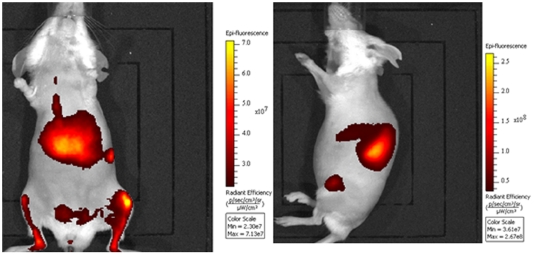
Fluorescence imaging of patient AML cells bearing mice performed 24h after intravenous injection of fluorescent CD45 mAb (ventral and lateral views).